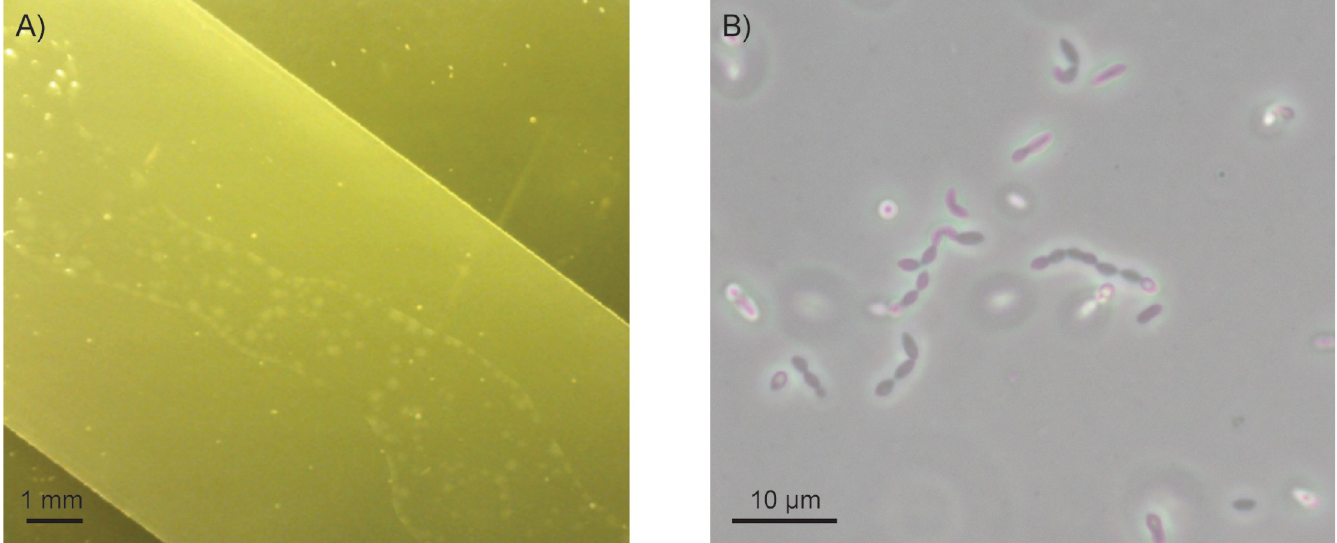
Fig 1. Photographic images. A) A close-up photograph of microbial growth on a PAO chip that was placed on top of CP agar. The chip was inoculated with 10-fold diluted cryo-preserved faecal sample from patient 188. The area that was inoculated is visualized as a smear in which individual microbial colonies can be distinguished. The white dots in the picture represent air bubbles in the agar medium. B) A light microscopy picture of the strain corresponding to OTU3088 that was isolated by a targeted approach. The strain shares 99% 16S rRNA gene identity with S . intestinalis BR72 T .